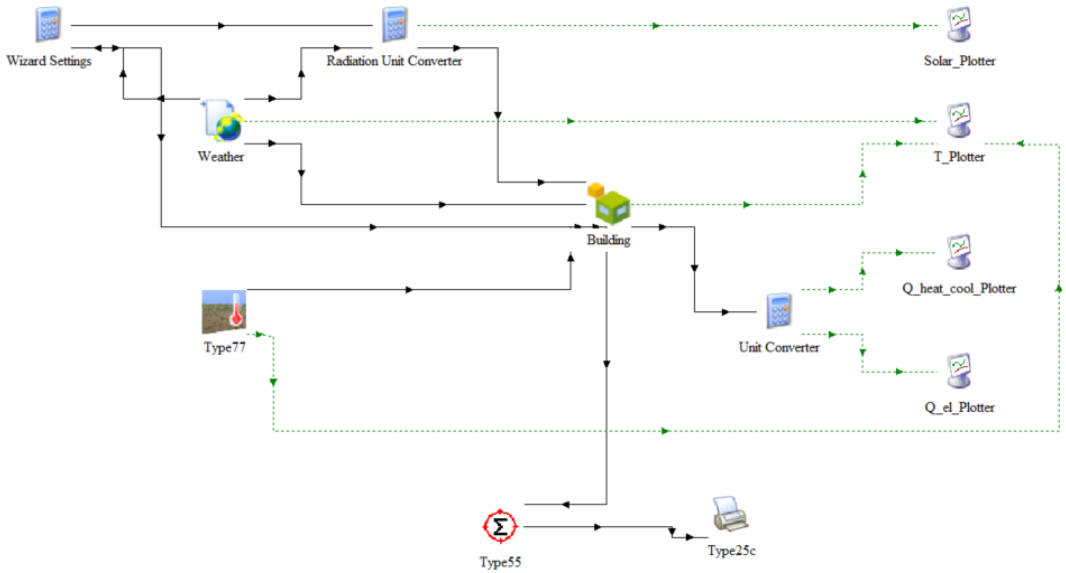
Figure 3. Model of the building implemented in TRNSYS.